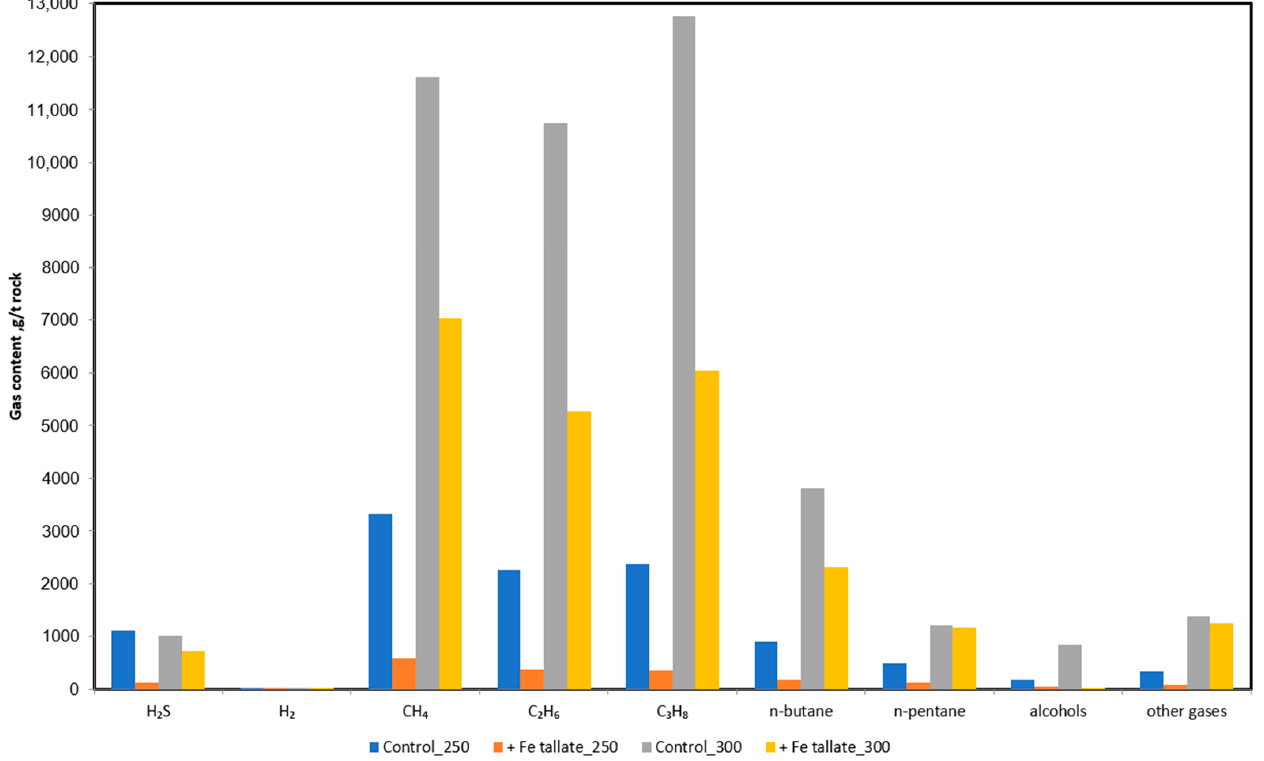
Figure 4. Content and composition of gases (individual gases, cycloalkanes and aromatic HCs, alcohols and other gases) depending on TST temperature and the presence of iron tallate.